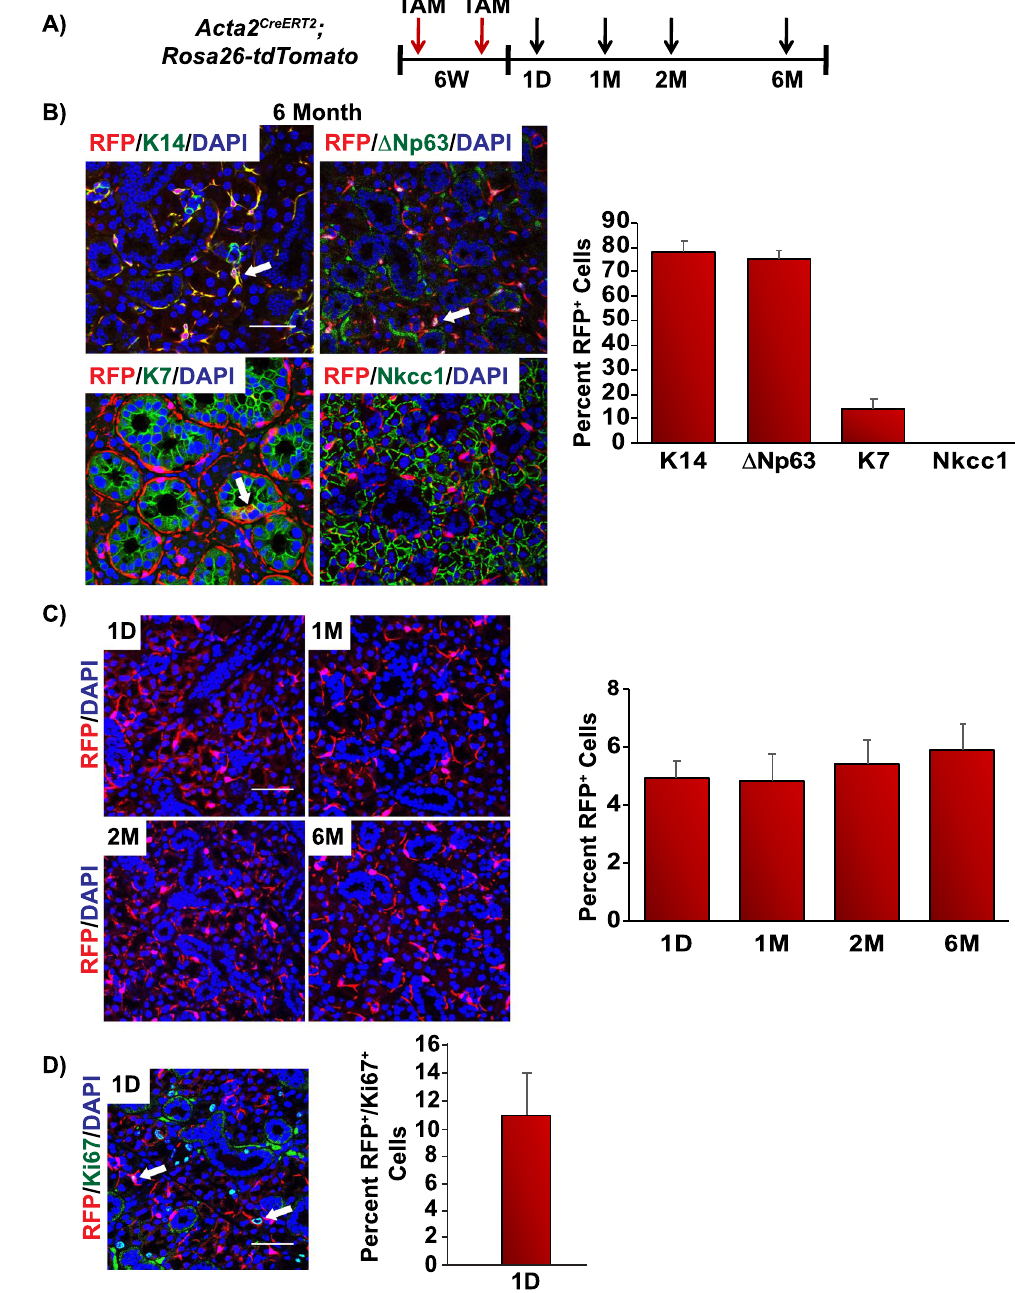
Figure 7. SMA + cells maintain the myoepithelial and ductal cell lineages in the adult submandibular gland. ( A ) Experimental timeline used for the genetic lineage tracing experiments in adult Acta2 CreERT2 ;Rosa26-tdTomato mice. RFP expression was induced by TAM injection in 6-week old adult mice and cells were traced for 1 day, 1, 2 and 6 months. ( B ) RFP expression was detected in the myoepithelial and ductal cell lineages (left panel). Quantification of the percentage of RFP + cells which co-express the various cell lineage markers as indicated (right panel). ( C ) Submandibular glands were evaluated for RFP expression 1 day (D) and 1, 2 and 6 months (M) following TAM administration (left panel). Quantification of RFP + cells per total number of cells (nuclei) counted in glands isolated at the indicated time points after TAM administration (right panel). ( D ) Co-staining of RFP and the proliferative marker Ki67 in adult submandibular glands 1 day after TAM administration (left panel). Quantification of RFP + /Ki67 + cells in submandibular glands, expressed as a percentage of total Ki67 + cells (right panel). Data are represented as mean ± standard deviation (S.D.). Arrows highlight double positive cells as indicated. D-day, M-month. Scale bar 37 μ m. n = 4